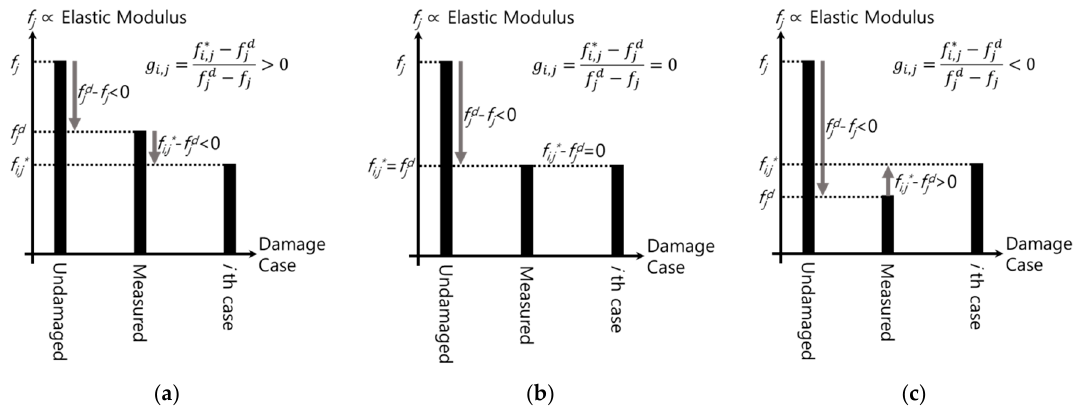
Figure 3. The concept of the rate of errors in detection (RED): ( a ) g i , j > 0; ( b ) g i , j = 0; ( c ) g i , j < 0